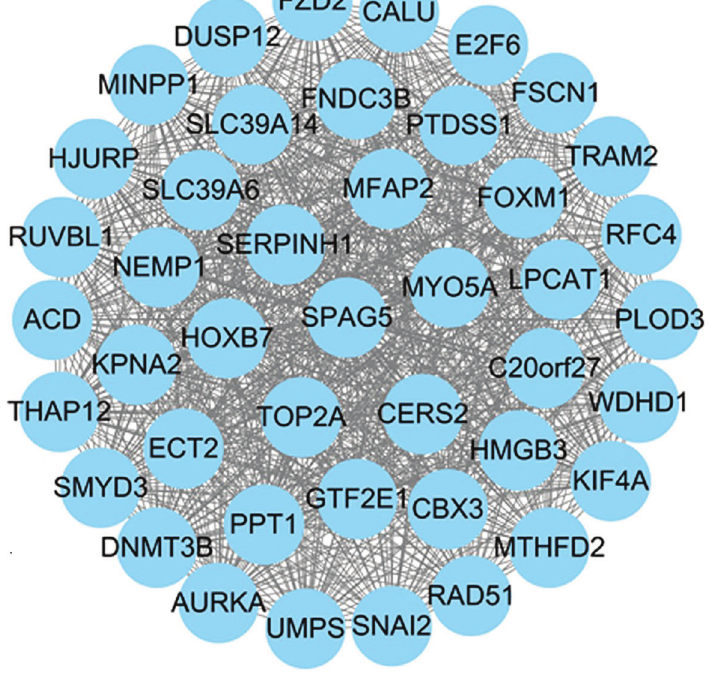
Figure 2. Differentially co-expressed network con- struction for esophageal squamous cell carcinoma based on differentially expressed genes.